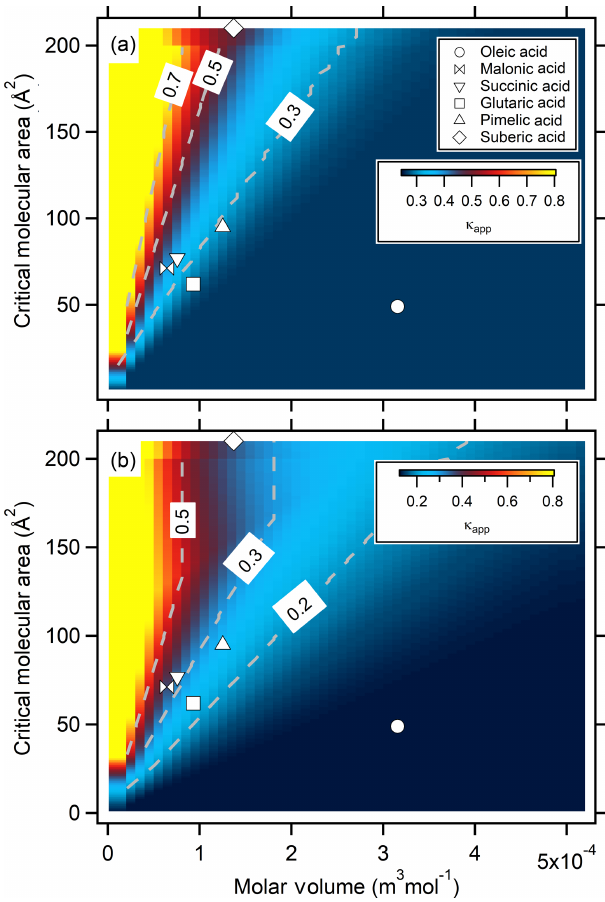
Figure 8. Apparent κ values calculated as function of critical molecular area (Å 2 ) and molar volume (m 3 mol − 1 ) from the film model, with the color corresponding to κ app . Results are shown for 80nm NaCl particles coated to organic fractions ( ε org ) of ei- ther (a) 0.80 or (b) 0.90. Also shown are the observed film model fit parameters for oleic acid (circle) from this study. Parameters for glutaric acid (square), succinic acid (upside down triangle), glutaric acid (square), pimelic acid (triangle), and suberic acid (diamond) are from Ruehl et al. (2016). The color scales for panels A and B range from 0.25 to 0.8 and 0.13 to 0.8, respectively, with the color scale saturating at